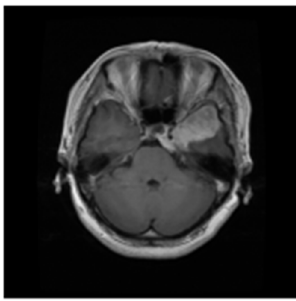
Figure 7: Input image.